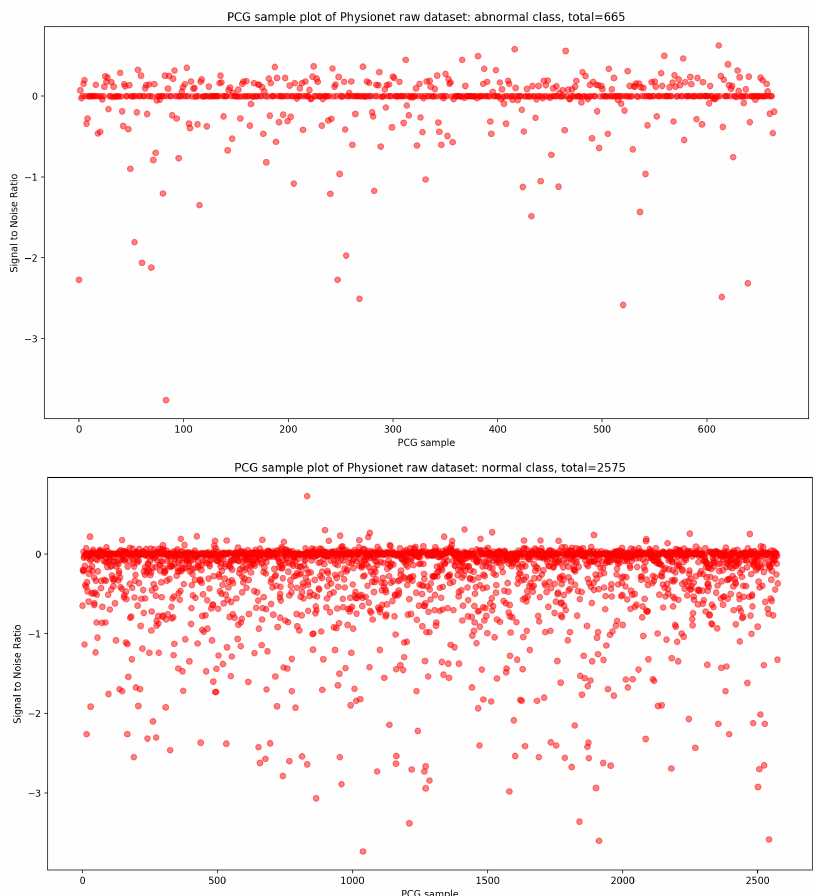
Figure 4. PCG sample distribution in function of signal-to-noise ratio of normal and abnormal